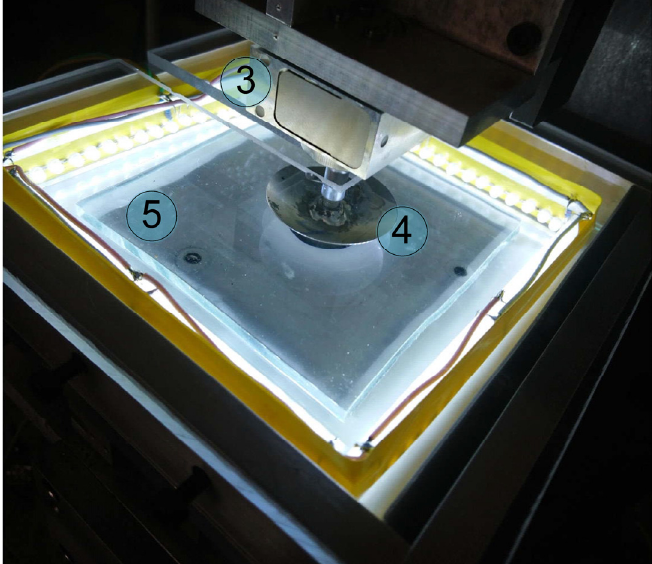
Figure 2. Detailed photo of the contact region: indenter (4), sensor (3) and elastomer (5). The all-sides lighting system consisting of 80 LEDs is also clearly visible.